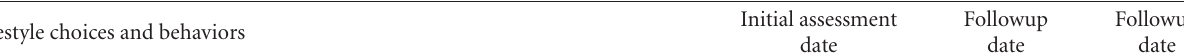
Table 2: Monitoring multiple health behavior change over time: short-form template for assessing and evaluating behaviors associated with chronic lifestyle-related